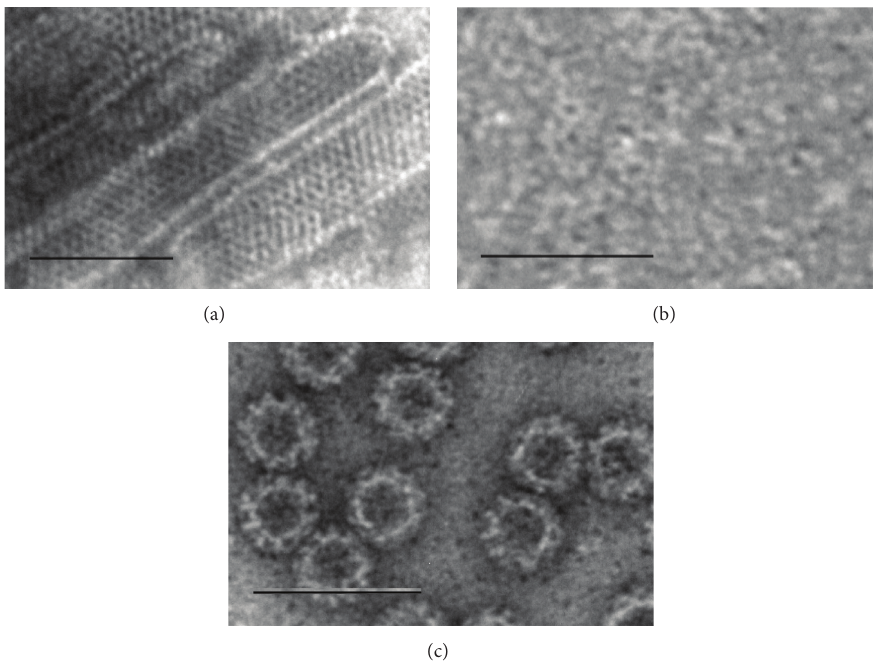
Figure 1: Structure and integrity of the proteins. Electron microscopy images of RV VP6 nanotubes (a), trimeric VP6 (b), and NoV GII.4 VLPs (c). Protein products were examined by FEI Tecnai F12 electron microscope (Philips Electron Optics, Holland) following negative staining with 3% uranyl acetate, pH 4.6. Bar 100nm. Images observed at 9300x (a and b) and 11,000x (c) magnification.